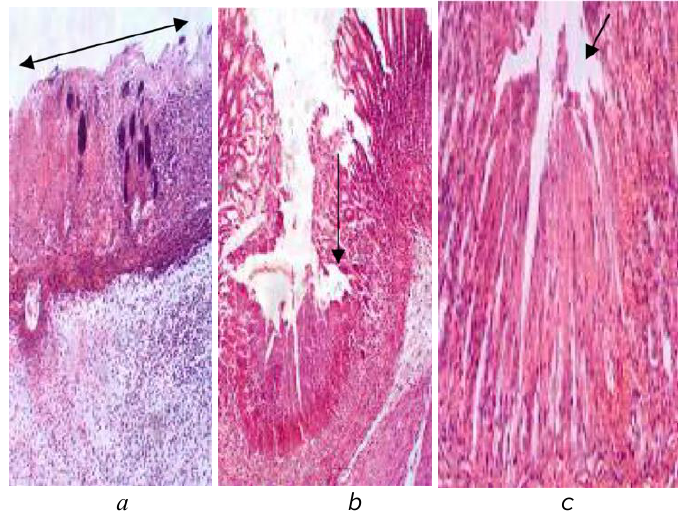
Fig. 3. The stomach of rats, which were introduced alcohol- prednisolone mixture. The ulcer defect in the: a – fundal; b – pylo- ric; c – prepyloric parts is spread over the entire depth of the mu- cous membrane. Haematoxylin-eosin.